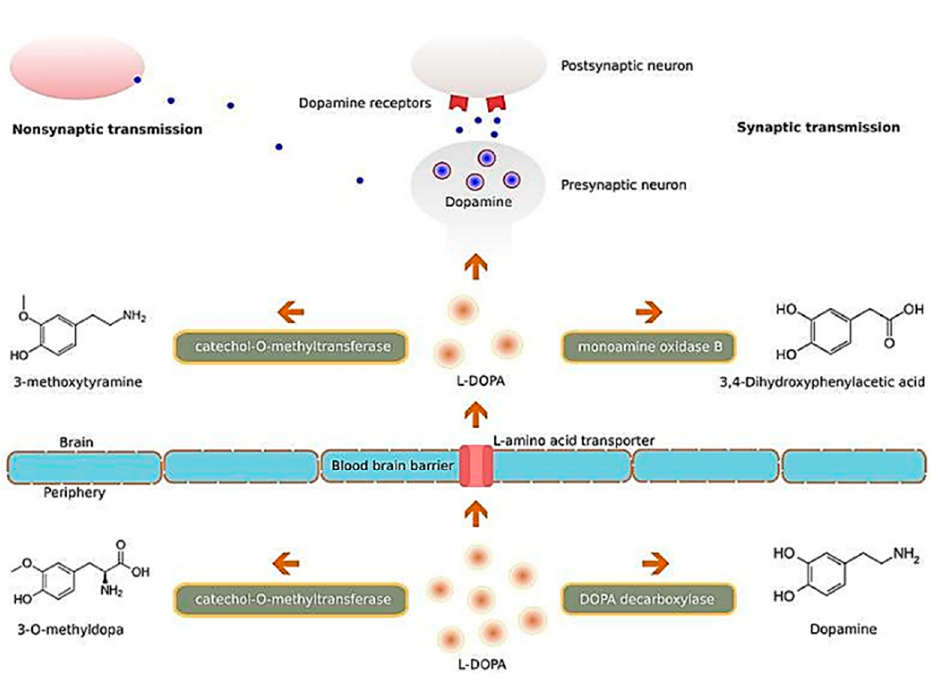
Figure 10. Illustration of the molecular mechanisms of L-DOPA. Abbreviation: L-DOPA: levodopa. Reproduced with permission from [159].